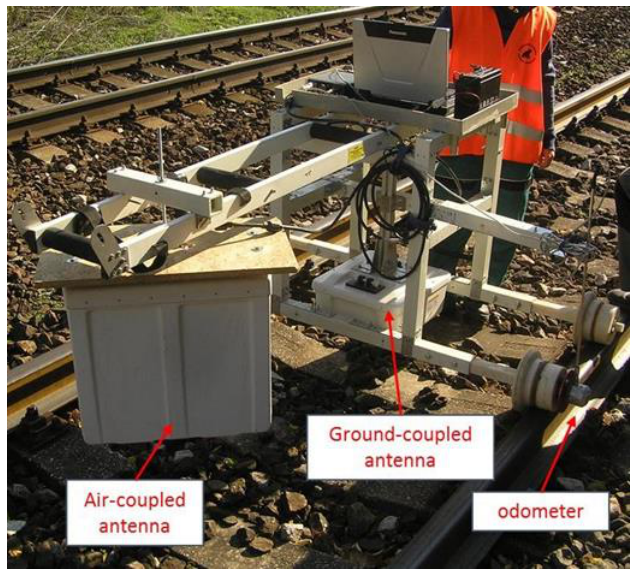
Figure 3. Ground Penetrating Radar (GPR) trolley designed for the surveys (air-coupled antenna in diagonal orientation). diagonal